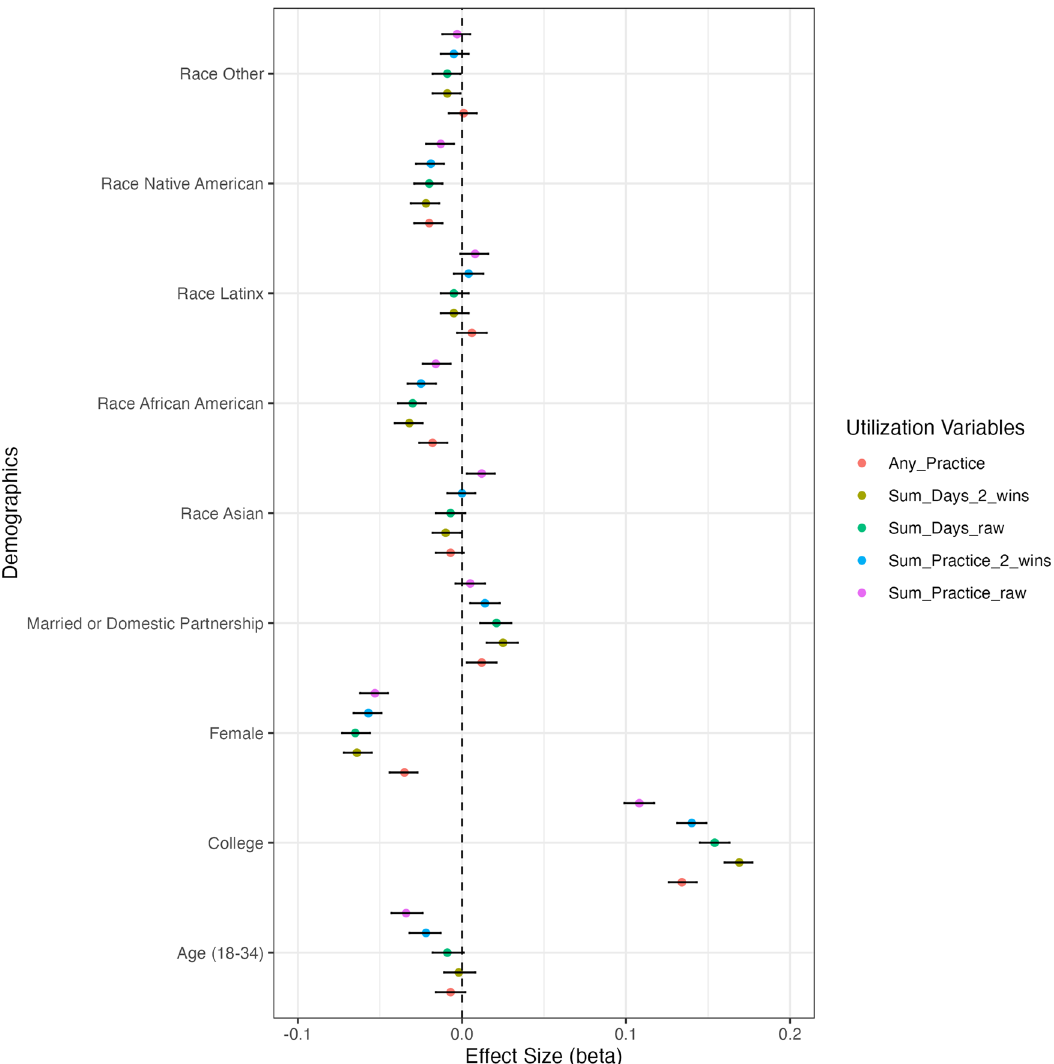
Fig. 1 Associations between demographics and HMP utilization. HMP Healthy Minds Program, Race Native American Race Native American and Paci fi c Islander; Age (<34), non-college-educated, unmarried/divorced, and NL White used as the reference group. Statistical test: multiple regression. Error bars represent the 95% con fi dence